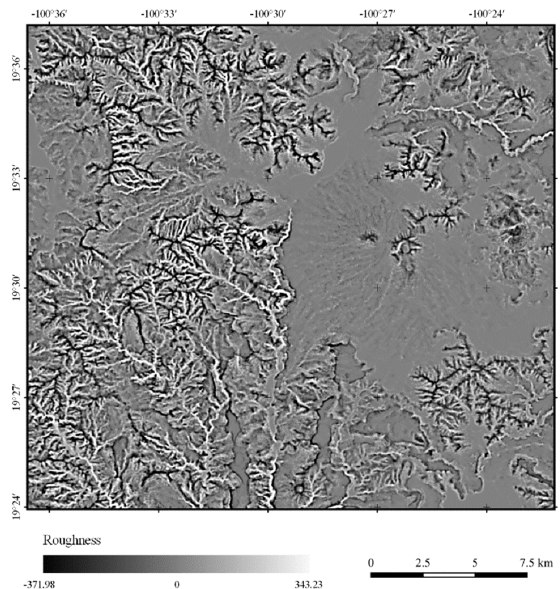
Figure 9 . Stretched image corresponding to DEM with 20 m resolution and 5×5 moving window.